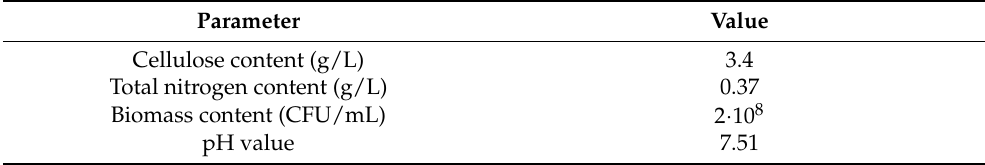
Table 3. Composition of the Bacillus sp. BioSol021s cultivation broth at the end of the cultivation and at the beginning of the flocculation.